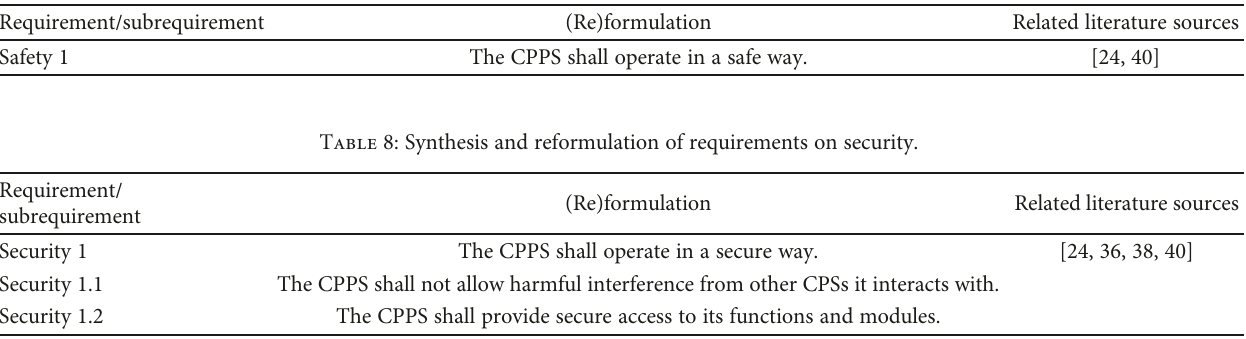
Table 7: Synthesis and reformulation of requirements on safety.